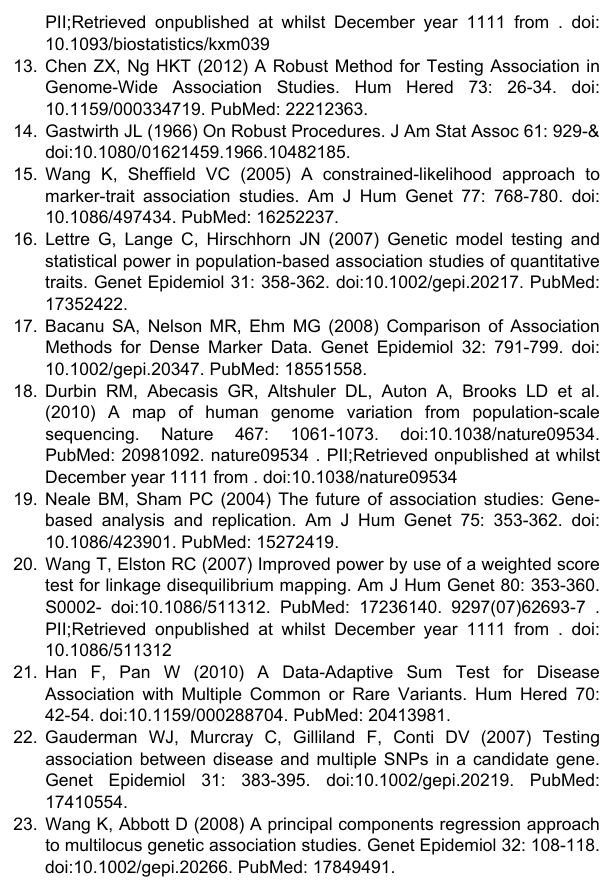
Table S1. Settings used in Experiment I.